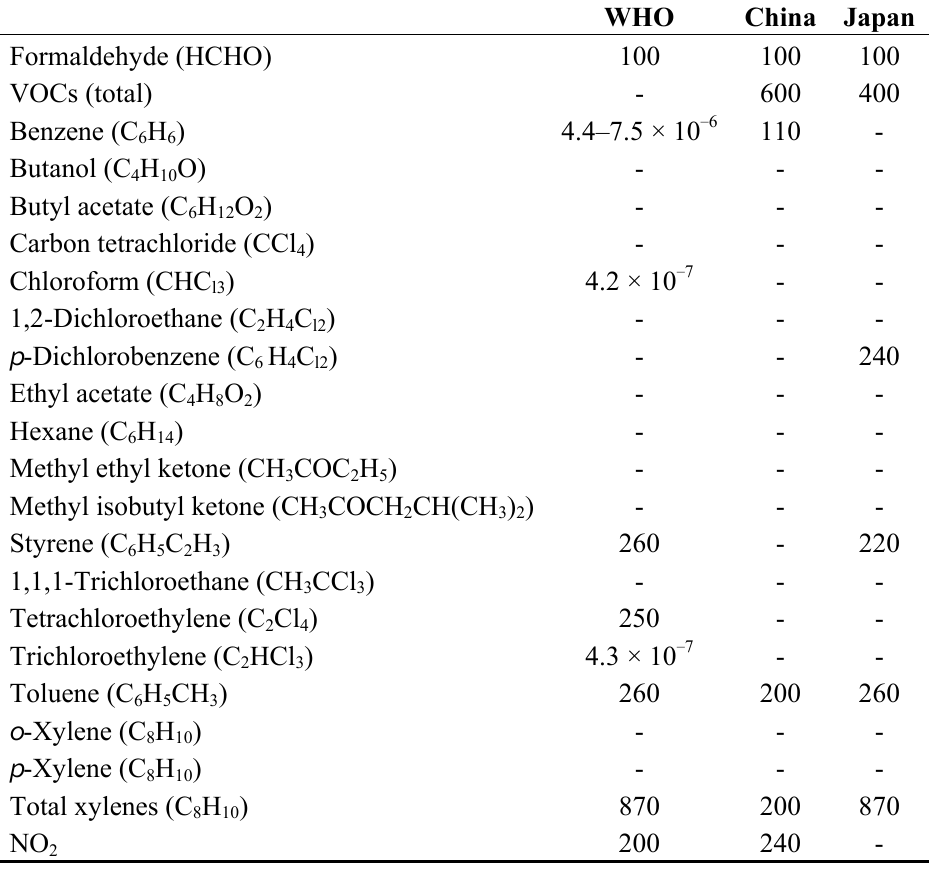
Table 1. Indoor exposure limits ( μ g/m 3 ) of WHO , China and Japan [15]. WHO China Japan Formaldehyde (HCHO) 100